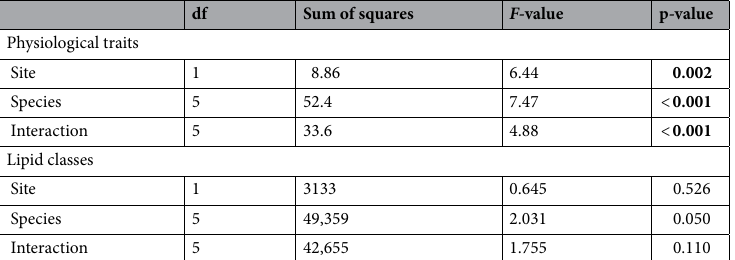
df Sum of squares F-